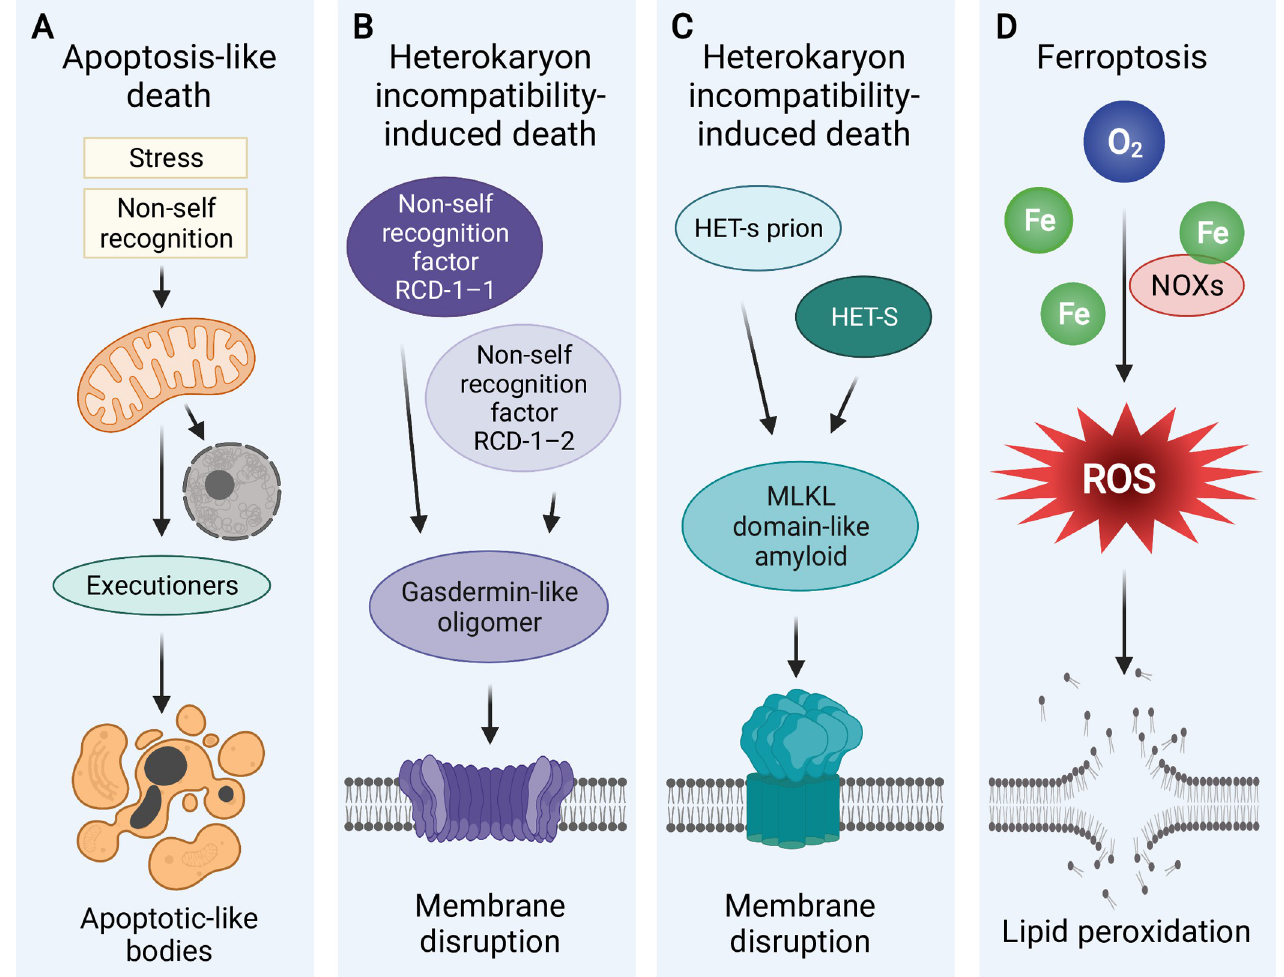
Fig 1. Types of RCD in fungi. (A) Apoptosis-like death elicited by stress [42] and vegetative/heterokaryon incompatibility [44], leading to degradation of various cellular targets and morphological hallmarks of apoptosis. (B) Heterokaryon incompatibility–induced death involving nonself-recognition factors RCD-1-2 and RCD-1-2 oligomerizing into the membrane disrupting gasdermin-like protein [47]. (C) Heterokaryon incompatibility–induced death involving the MLKL domain proteins oligomerizing into the amyloid membrane disrupting pore, as exemplified by interactions of the Podospora anserina proteins HET-S and HET-s [49]. D. Ferroptotic lipid peroxidation in Magnaporthe oryzae is attributed to ROS produced by NOXs activated by autophagically released cellular iron (Fe) [51]. MLKL, mixed lineage kinase domain–like; NOX, NADPH oxidase; RCD, regulated cell death; ROS, reactive oxygen species.